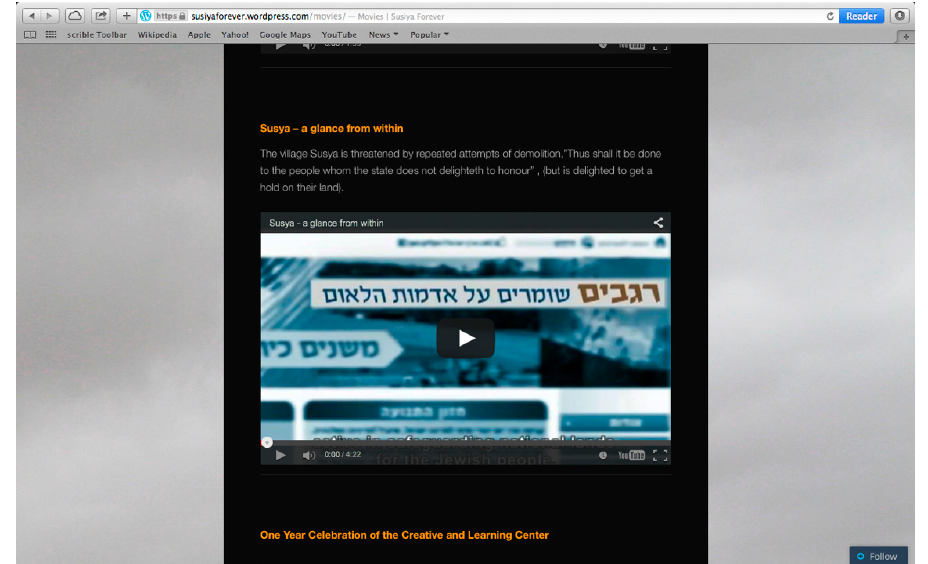
Figure 10. Embedded screenshot of the Israeli Social TV report within the Susiya blog page. (Accessed on 3 February 2015).